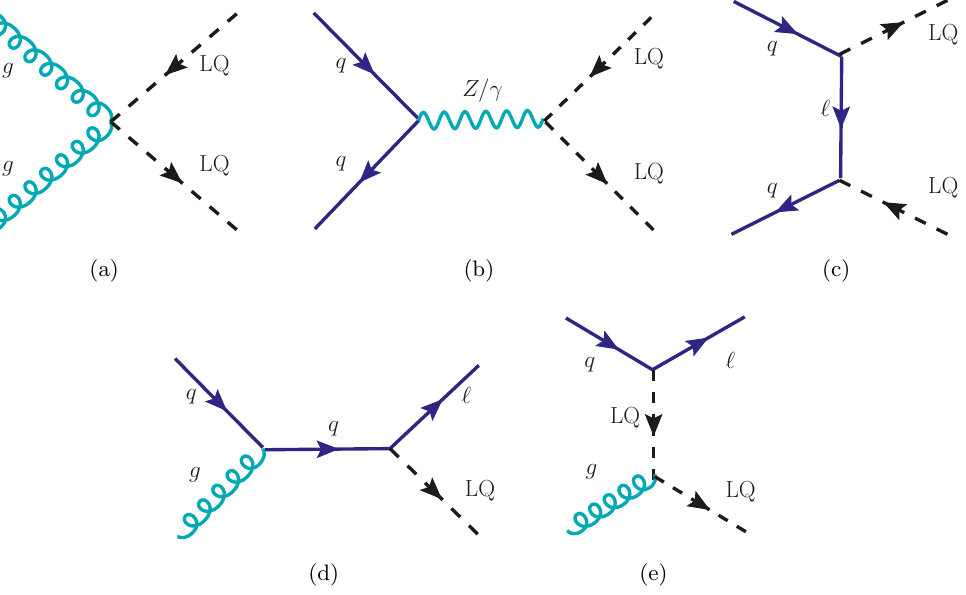
Figure 28 . Feynman diagrams for pair- and single-production of LQ at the